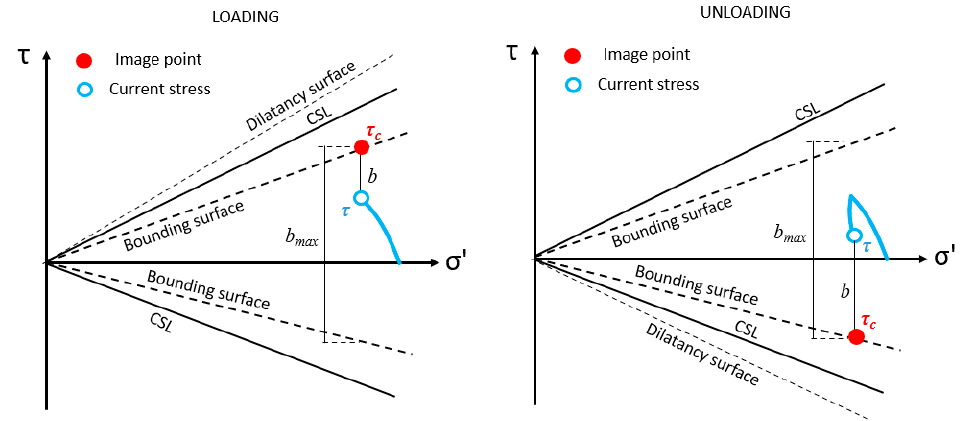
Figure 6. Model for undrained shearing of the representative soil element.